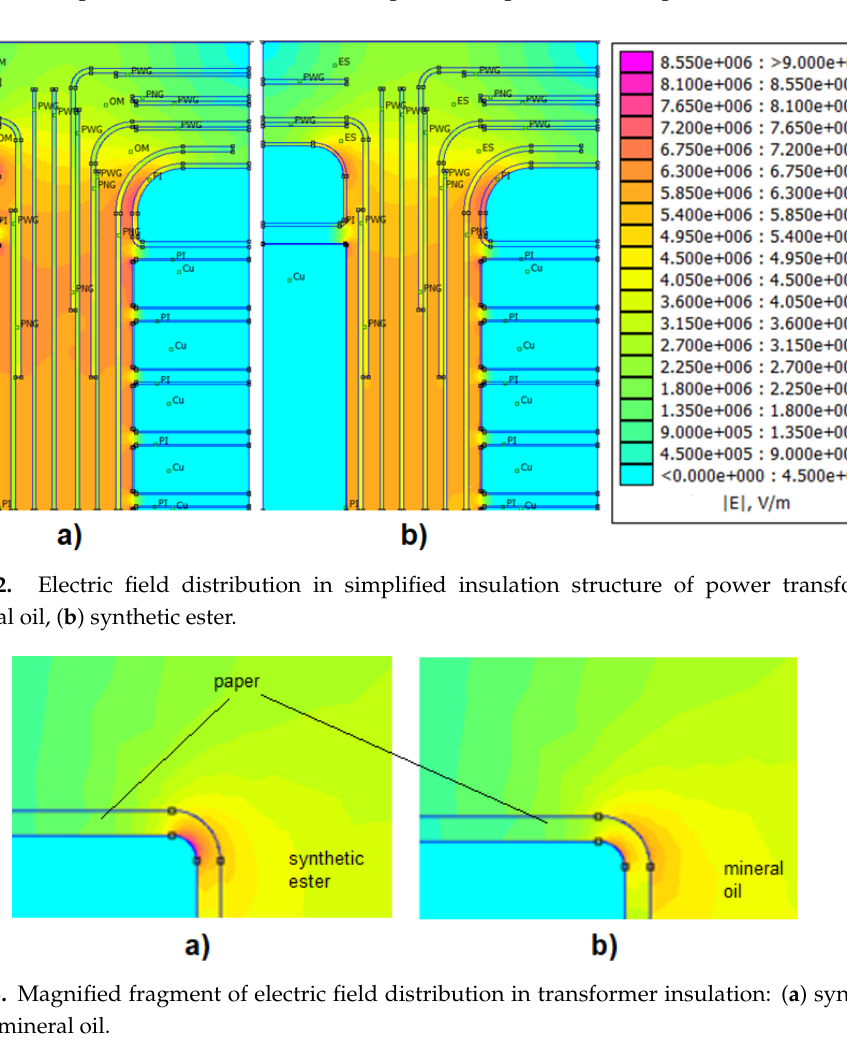
Figure 13. Magnified fragment of electric field distribution in transformer insulation: ( a ) synthetic ester, ( b ) mineral oil.